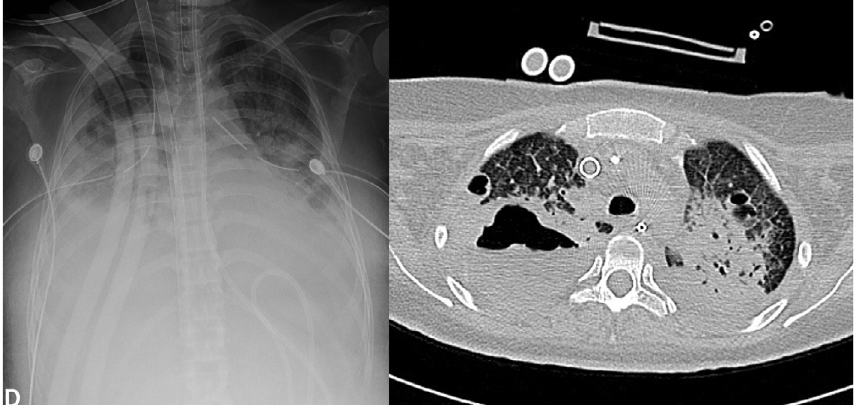
Figure 1. Patient’s lung contusion at the initial evaluation. Thorax anteroposterior radiographs and thoracic CT showing extensive lung contusion.